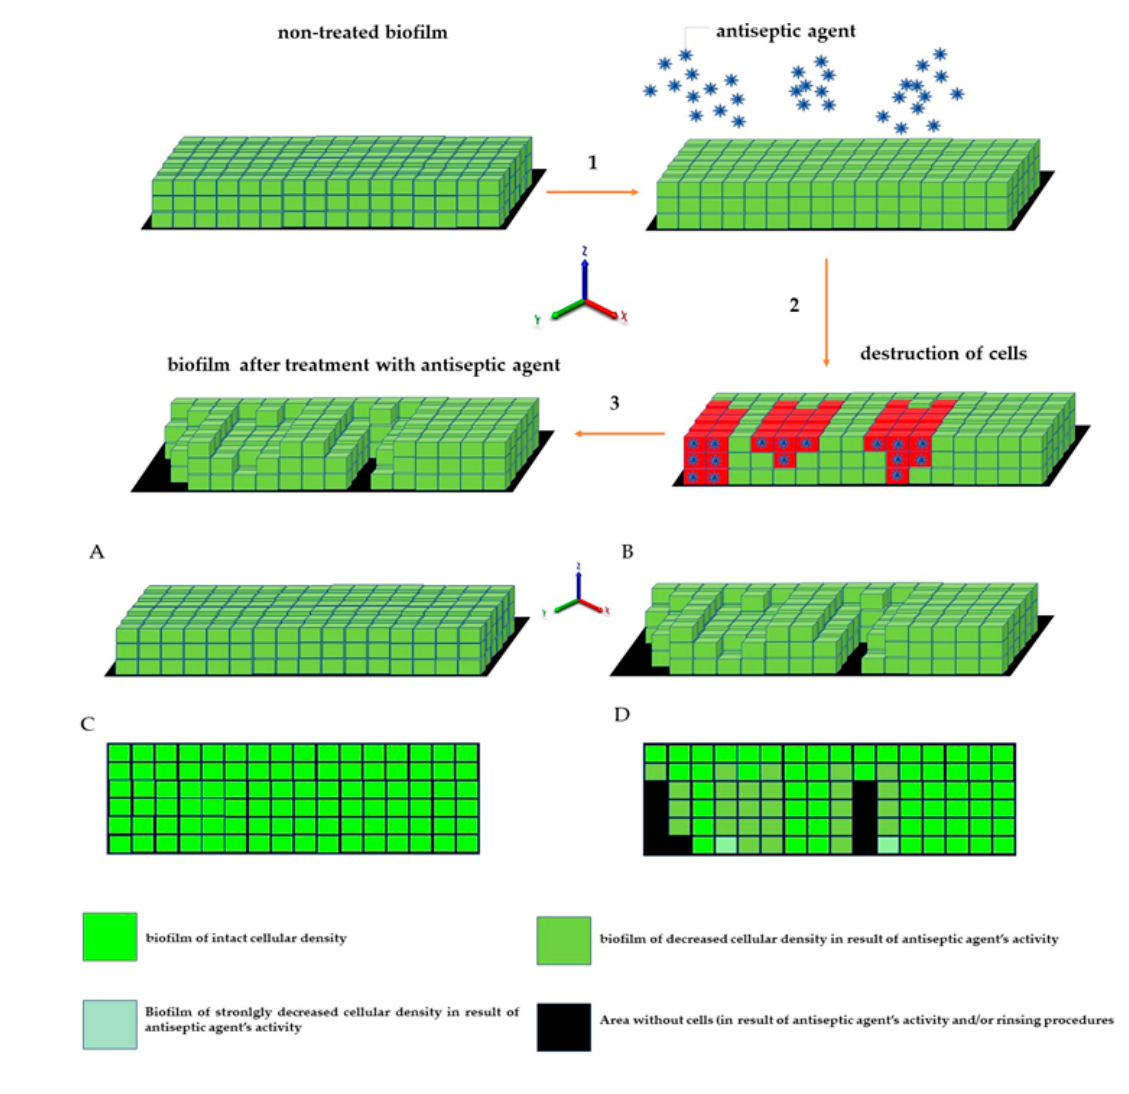
Figure 12. Schematic presentation of the phenomena occurring during antiseptic activity against biofilm reflected in the formation of “holes” and in a drop in fluorescence intensity. For picture clarity sake, the staphylococcal cells are shown as cubes, while intact biofilm formed by the cells is presented as an even (with regard to height) structure. (1)—introduction of antiseptic agent to biofilm; (2) antiseptic agent activity; (3) destruction of cells (resulting from antiseptic agent activity) and removal of cells (resulting from antiseptic agent activity and rinsing). ( A , C )—intact biofilm in 3D and -xy plane, respectively; ( B , D )—biofilm after the application of antiseptic in 3D and -xy plane, respectively.